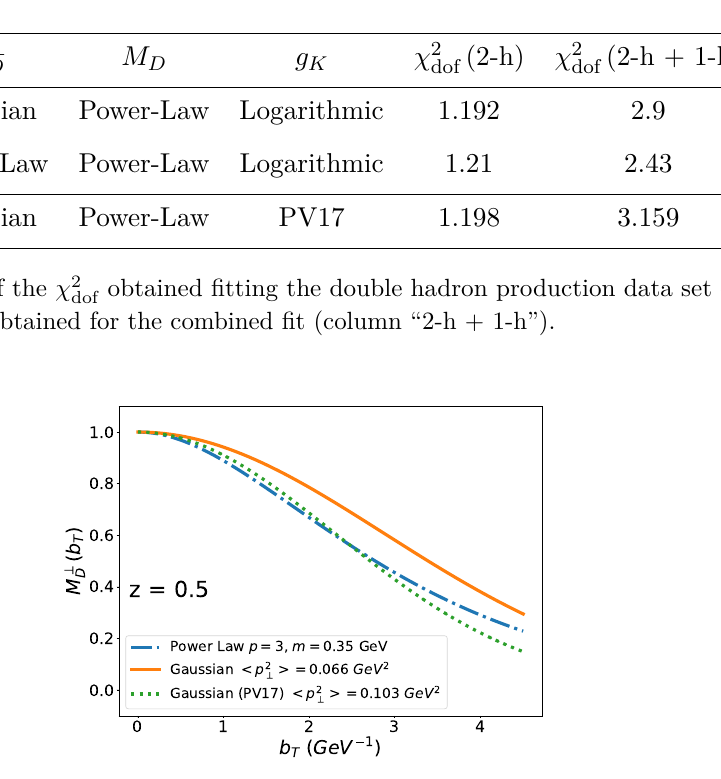
Figure 5 . Nonperturbative functions extracted from the double-hadron data fit: Gaussian (orange solid line), Power-Law (blue dash-dotted line) and PV17 Gaussian (green dotted line)